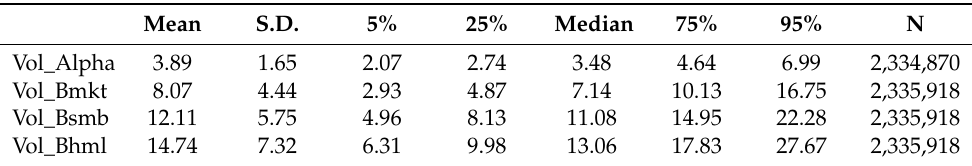
Table 1. Summary Statistics.